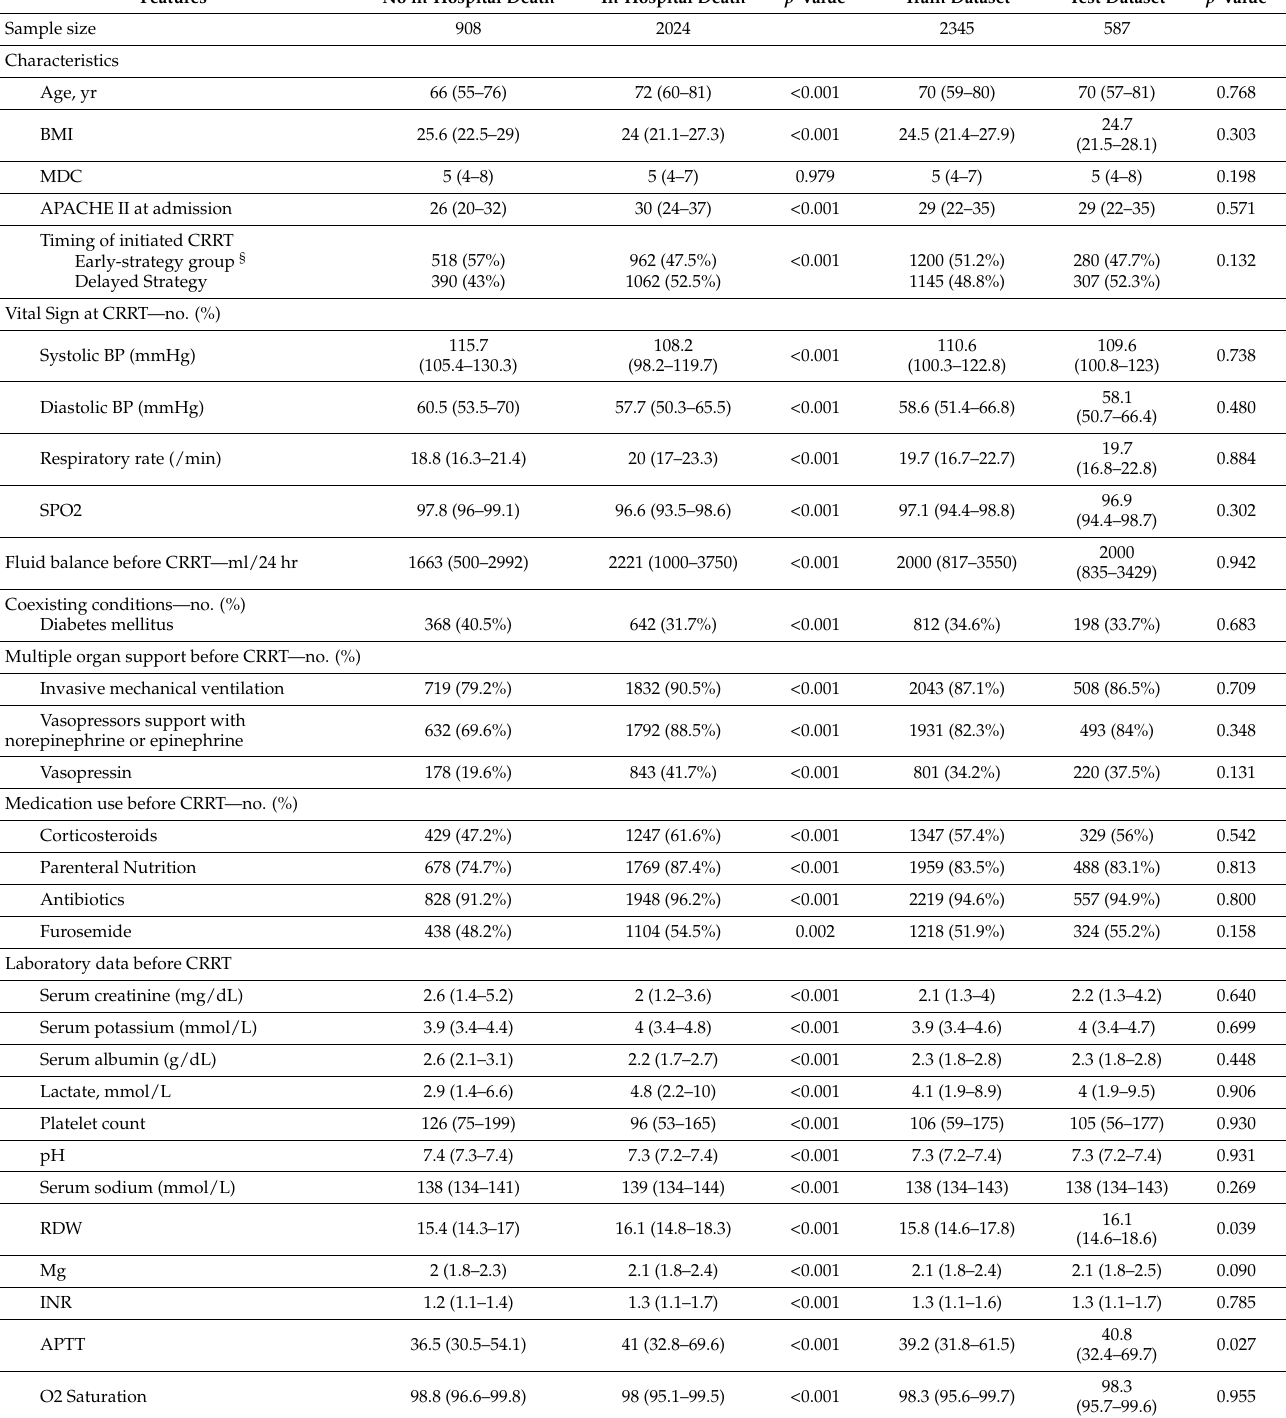
Table 1. Patients’ features in overall cohort and split